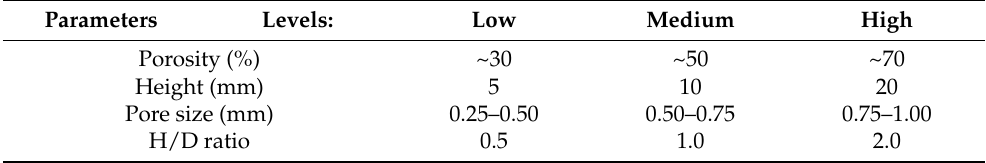
Table 2. Scaffold test specimen geometries, constant diameter of D = 10 (mm). Parameters Levels: Low Medium High Porosity